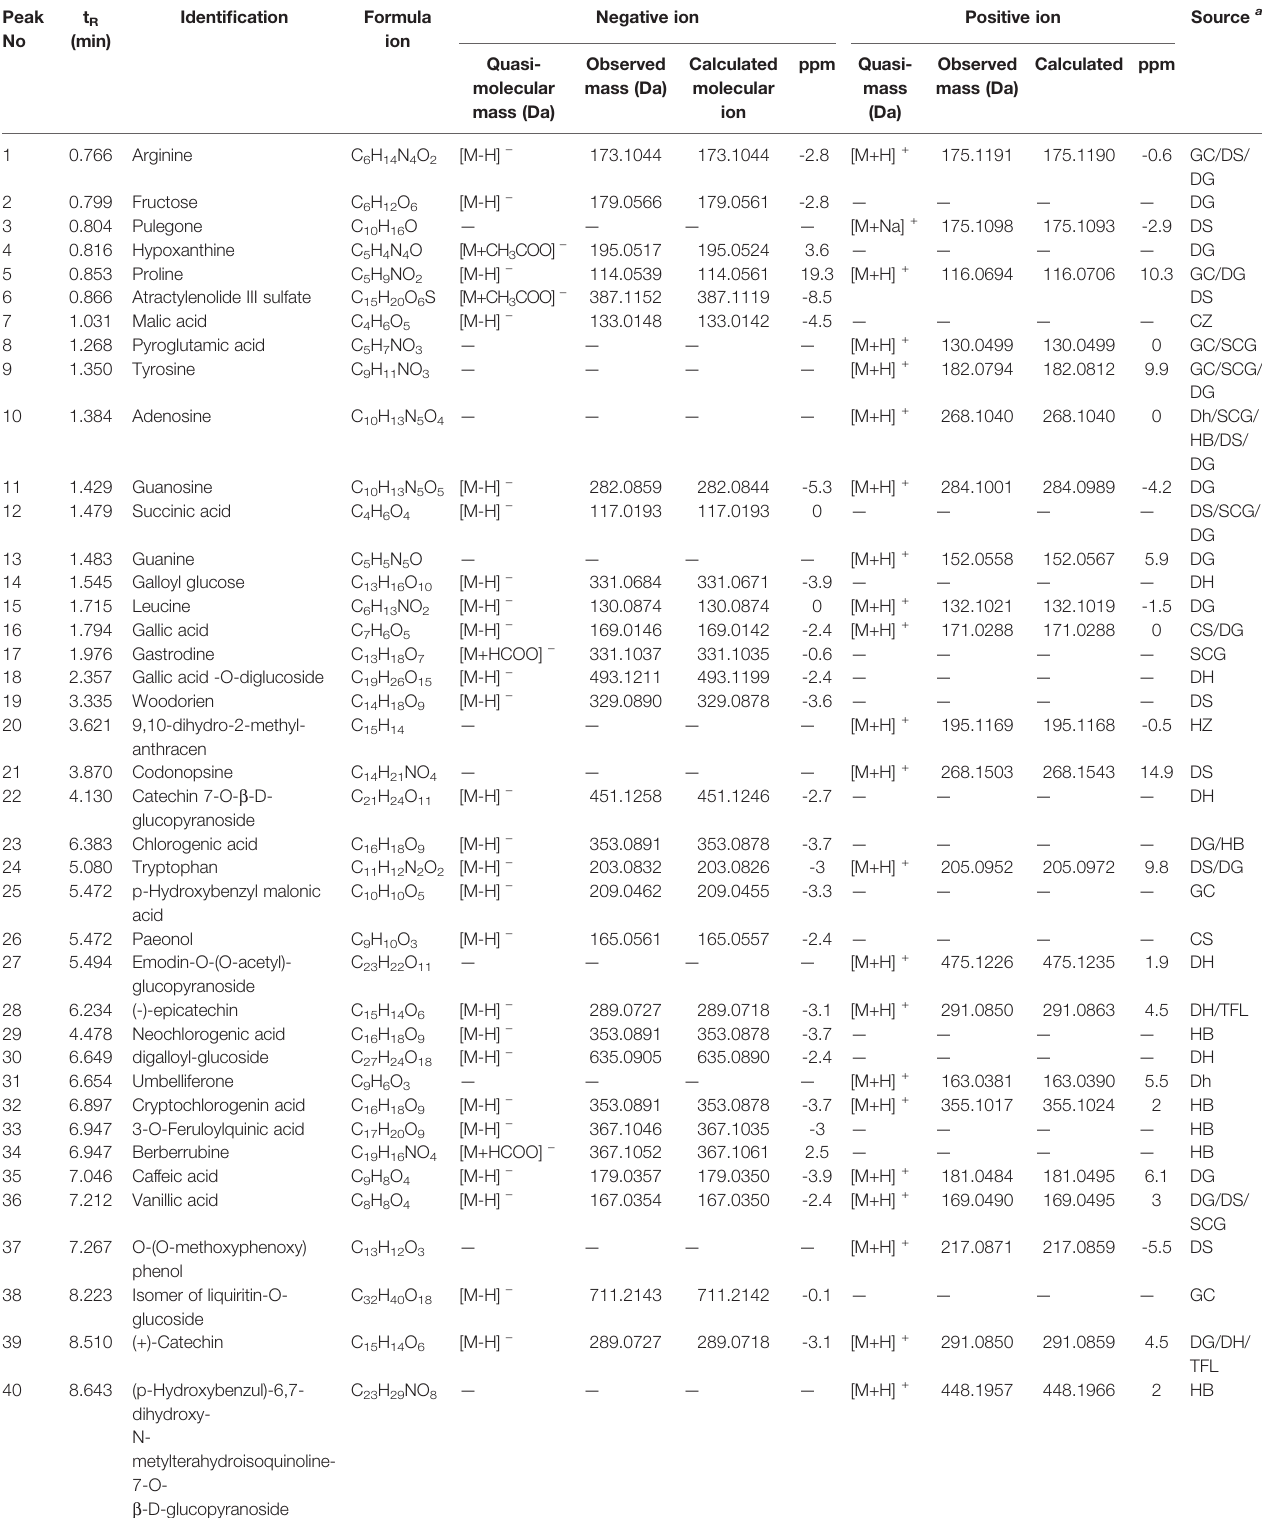
TABLE 1 | Characterization of the chemical constituents in Jiang-Suan-Chu-Bi recipe (JSCBR) by ultraperformance liquid chromatography coupled with quadrupole time-of- fl ight mass spectrometry (UHPLC-QTOF-MS). Peak